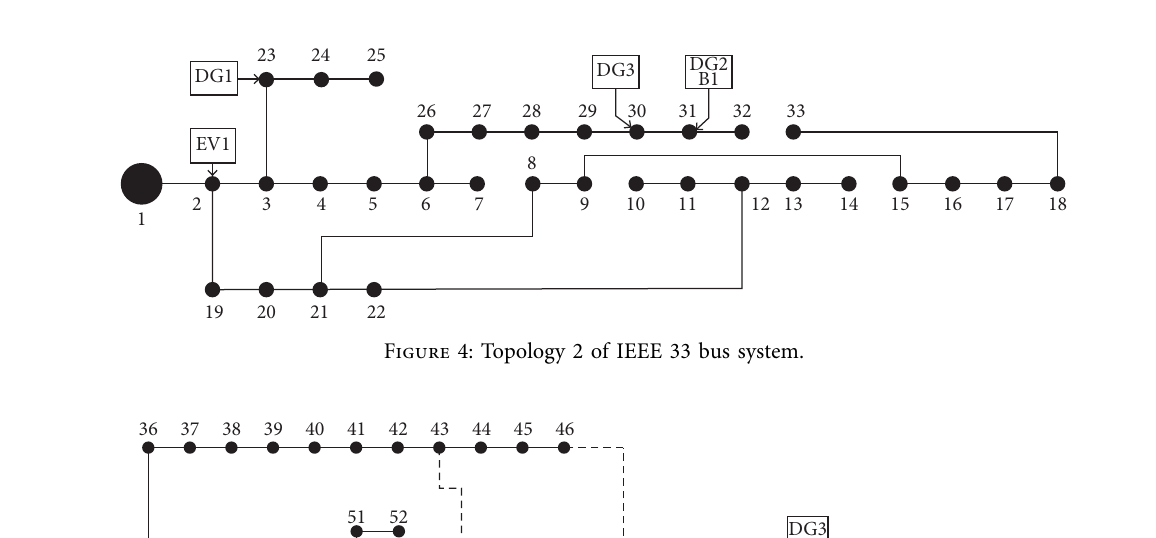
Figure 3: Topology 1 of IEEE 33 bus system.